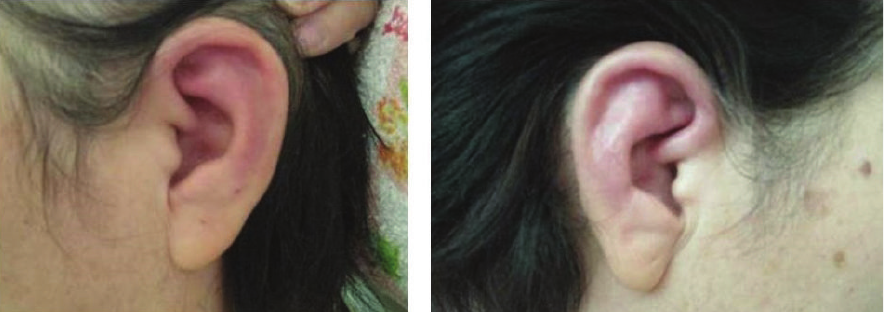
Figure 1: Inflammation of both ears. Obvious redness of the auricularis in this patient.